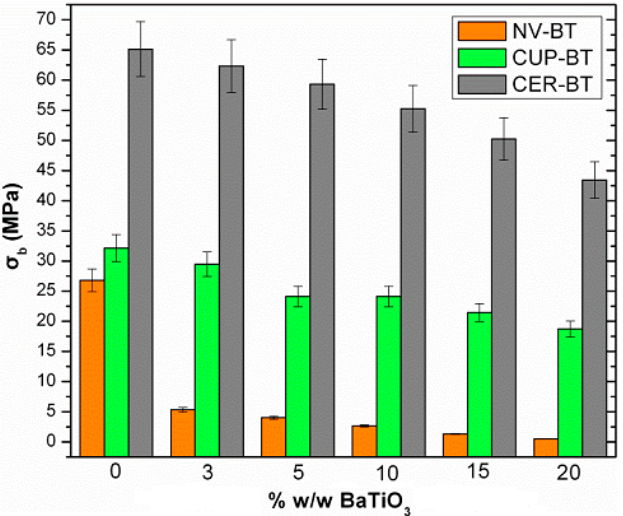
Figure 7. Bending strength values for some of the developed nano-composite specimens.